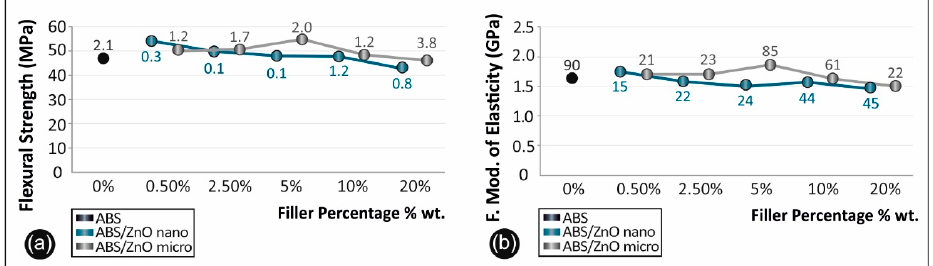
Figure 10. ( a ) Comparative flexural strength graph and ( b ) flexural mod. of elasticity for all the materials studied (numbers in the graph points indicate the calculated deviation for each value).